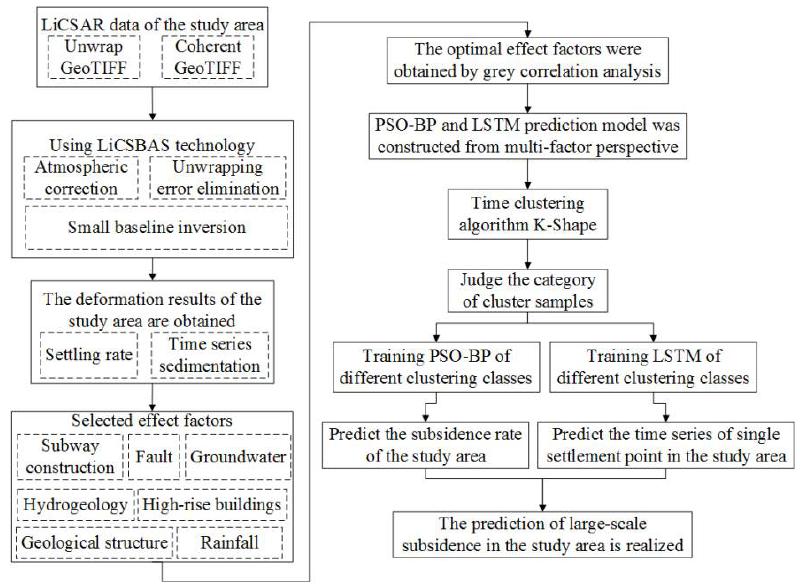
Figure 3. Flowchart of the method (the dotted box represents the method or generated content that needed to be processed in the solid box).